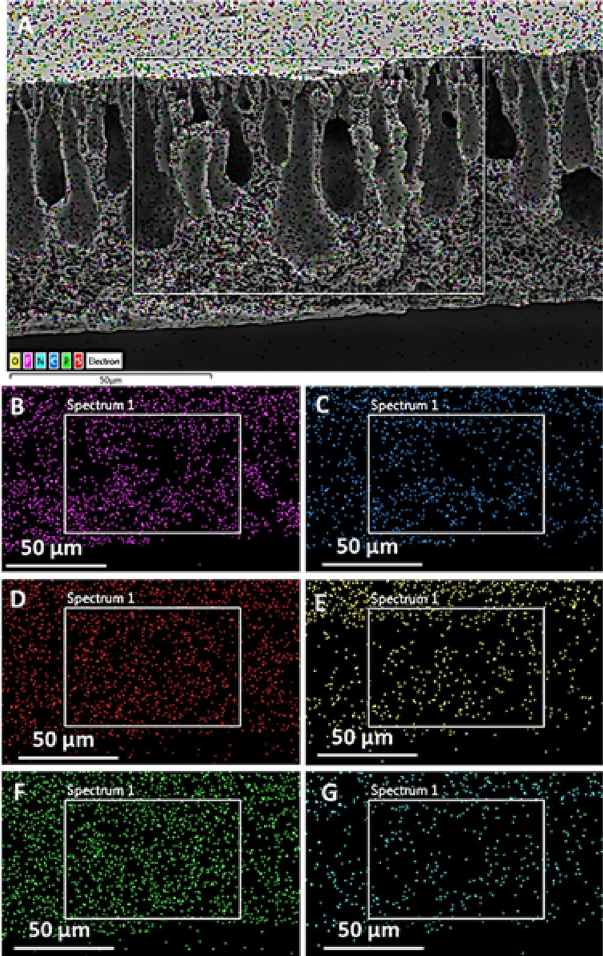
Figure 6. Mapping of PP 5 incorporated PVDF membrane ( A ) complete distribution of elements on the membrane, ( B ) F Kα, ( C ) C Kα, ( D ) S Kα, ( E ) O Kα, ( F ) P Kα, ( G ) N